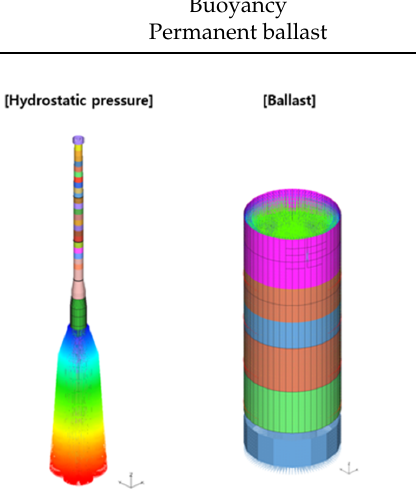
Figure 12. Visual representation of structural loads.